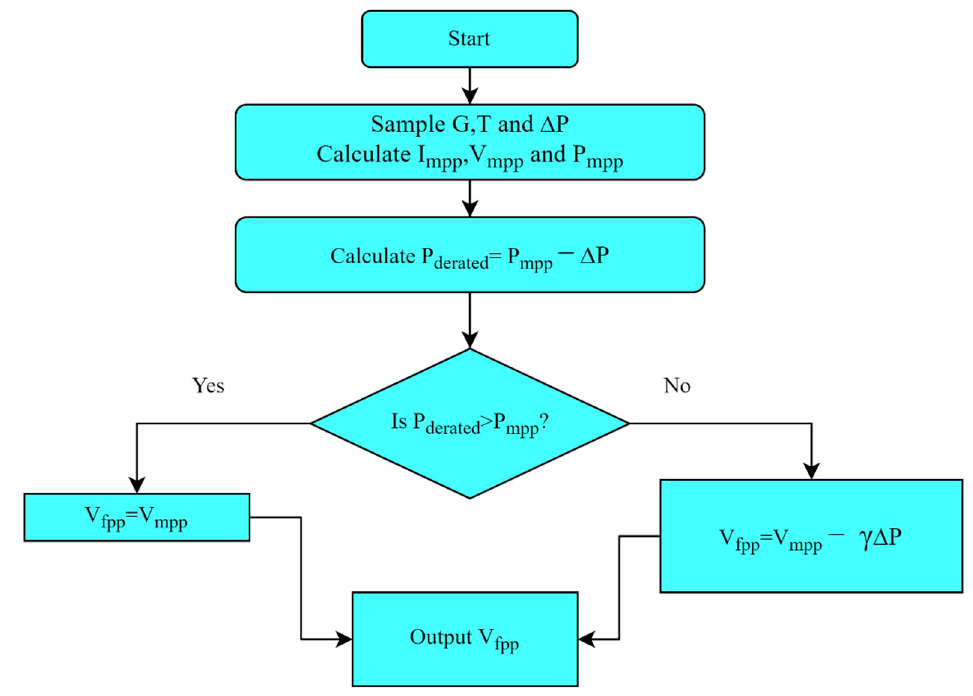
Figure 4. The FPPT control